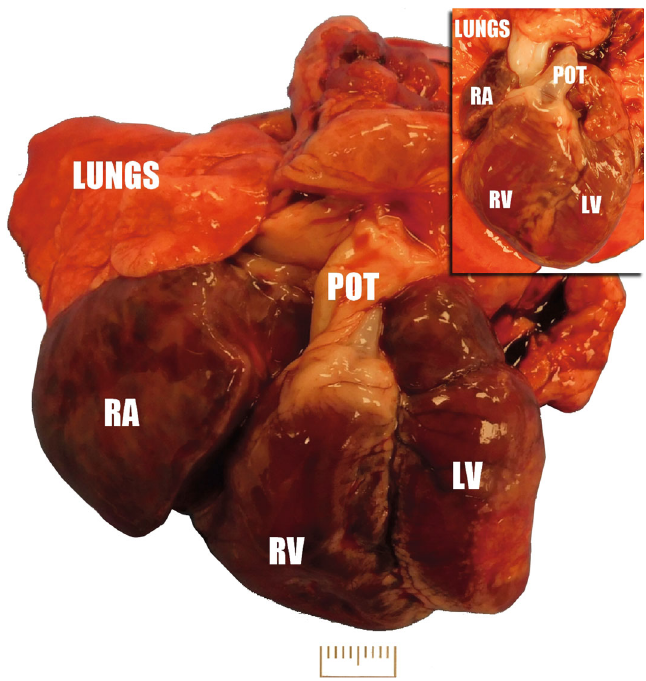
Figure 1: Gross image of the heart and lungs — caudal view of the heart illustrating a markedly enlarged right atrium (RA) and an enlarged right ventricle (RV). The left ventricle (LV) was slightly smaller than the right ventricle. Lungs were partially compressed by the enlarged heart, were moist and exuded fl uid on sectioning, and had a rubbery texture. The pulmonary artery and entire pulmonary out fl ow tract (POT) were also enlarged and dilated. Inset: an image of an age-matched rabbit is provided for comparison. Scale bar = 1 cm.